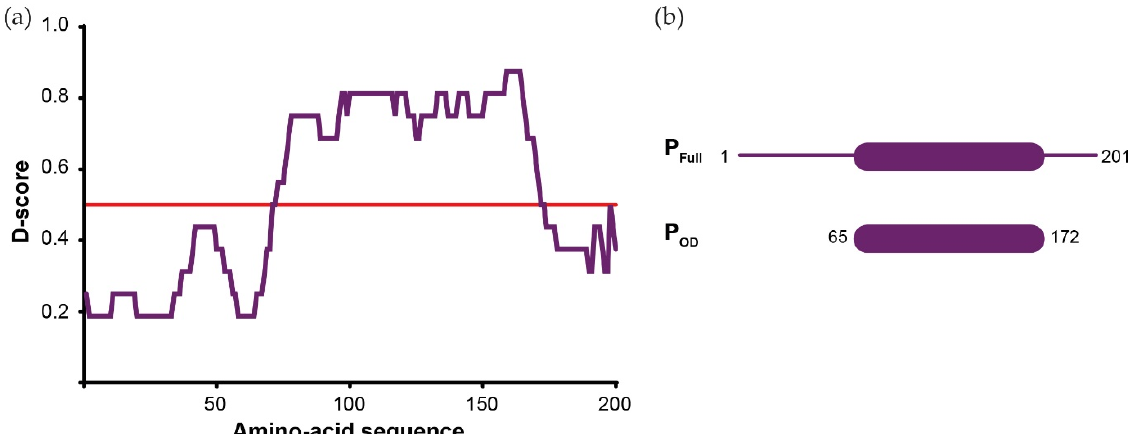
Figure 1. Predicted architecture of BoDV-1 phosphoprotein. ( a ) D-score (score for disorder as a function of residue) of BoDV-1 P. The prediction was based on 16 predictor web servers and the D-score was calculated by adding the values for each residue and dividing by the number of used algorithms. We arbitrarily defined a threshold level at 0.50. Residues with a D-score <0.50 were assigned as disordered [84]. ( b ) Scheme of the BoDV-1 P constructs designed for this work based on the bioinformatics analysis.